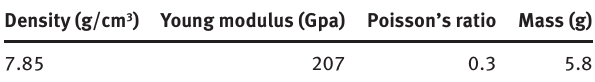
Table 1: Material parameters of